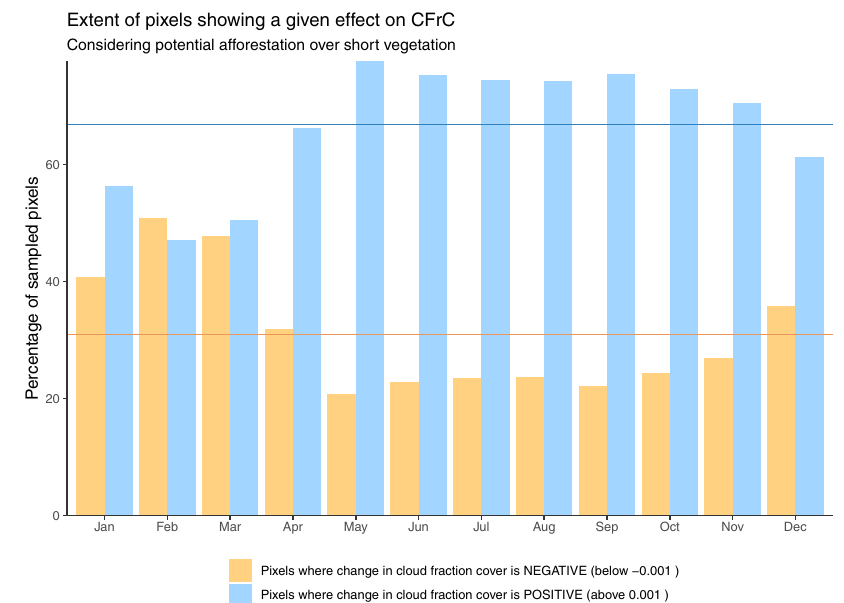
Fig. 2 Seasonal patterns of the percentage of sampled pixels where forest has a positive (blue) or negative (yellow) in fl uence on the cloud fractional cover (CFrC). For the Southern Hemisphere, the months have been cycled by 6 months. The horizontal lines represent the annual average.